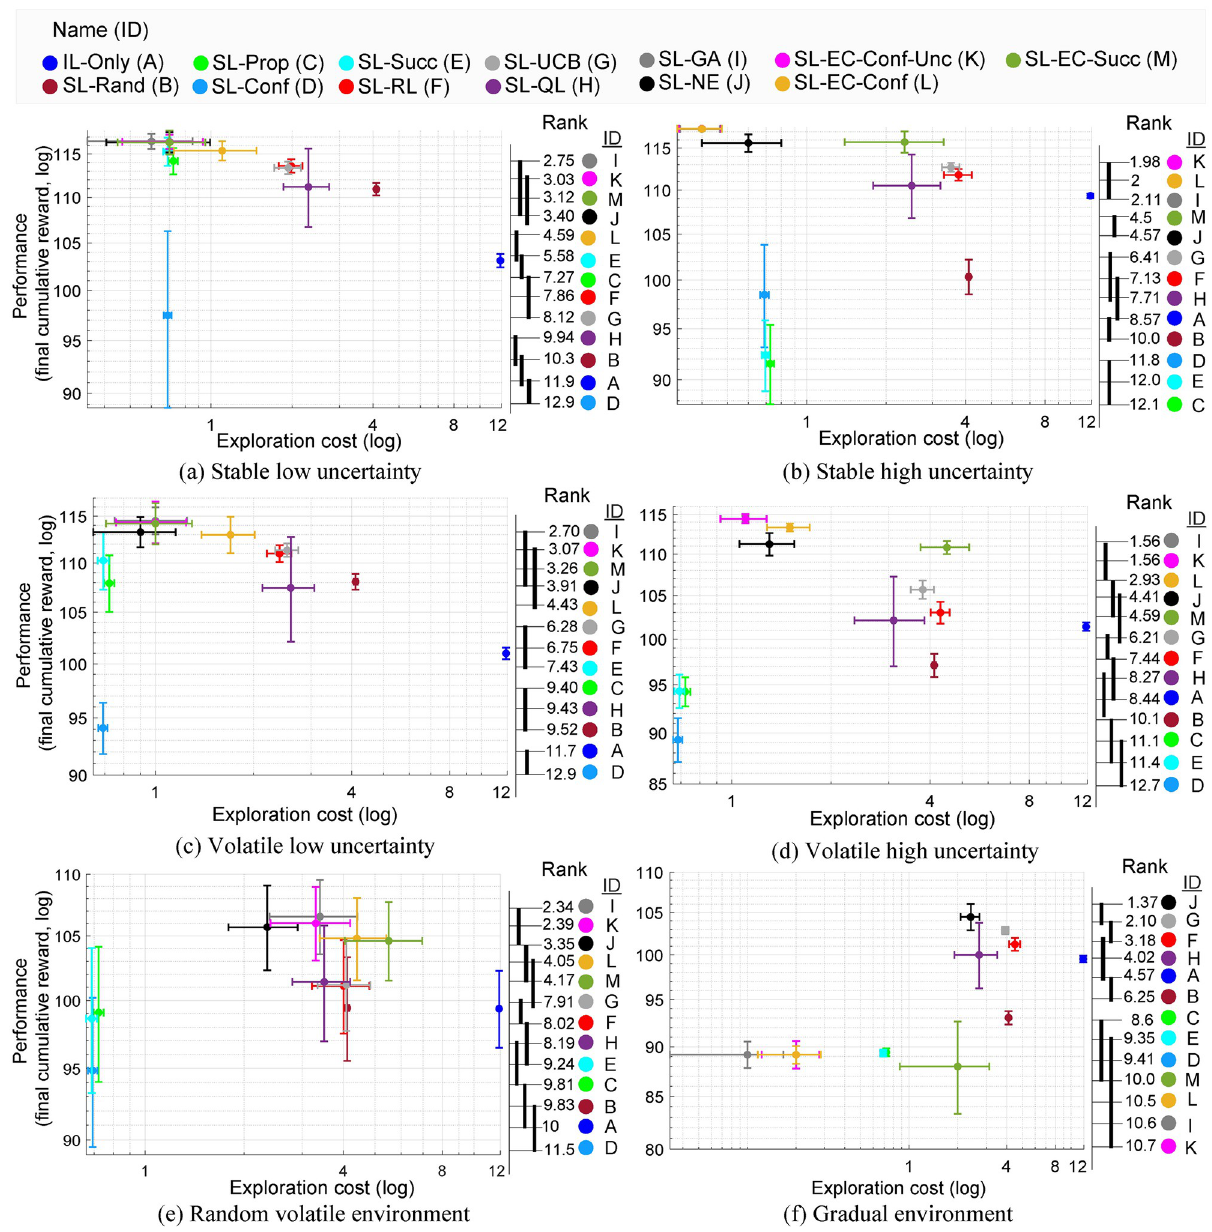
Fig 4. SL-GA and SL-EC-Conf-Unc show the best performance vs. exploration cost on diverse set of environments. Overall, the meta-social learning strategies that utilize conformist strategy show better performance environments with high uncertainty. On the right of each figure, the color coded labels indicate the meta-social learning strategies (A through M maps to the strategy with the same color shown on top), and are ranked based on their performance from the best to worst. The decimal numerals on the left of the color codes indicate their average ranks (the lower is the better). The strategies are linked with vertical bold lines if the differences in their average ranks are not statistically significant at α = 0.05 based on the post-hoc Nemenyi